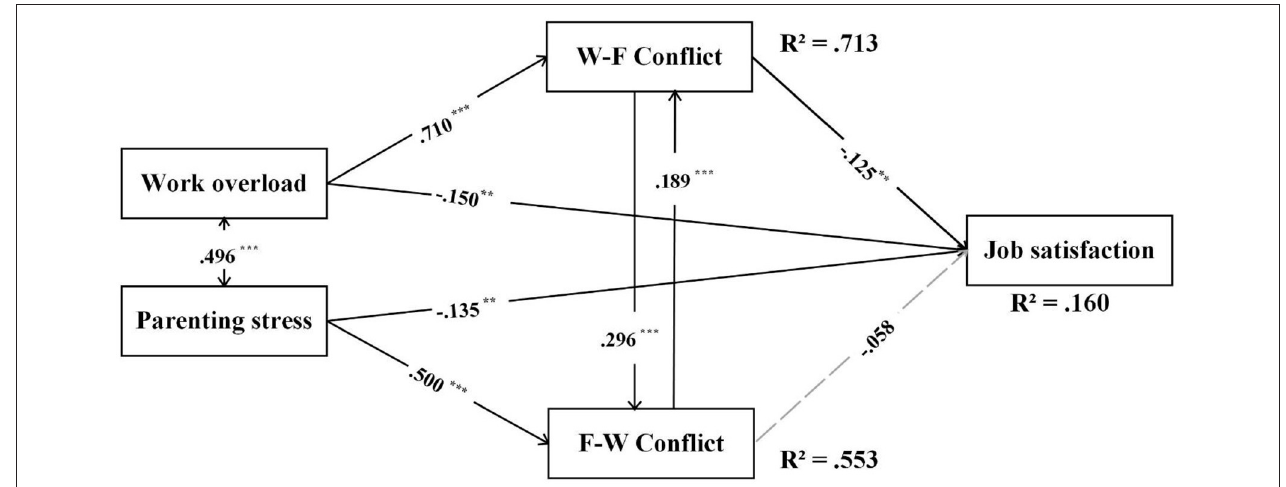
FIGURE 3 | Indirect effect model among work overload, parenting stress, work-to-family conflict, family-to-work conflict, and job satisfaction. W-F conflict, work-to-family conflict; F-W conflict, family-to-work conflict. All the reported parameters are standardized. For clarity, covariates are not shown in the figure. ** p < 0.01, *** p < 0.001